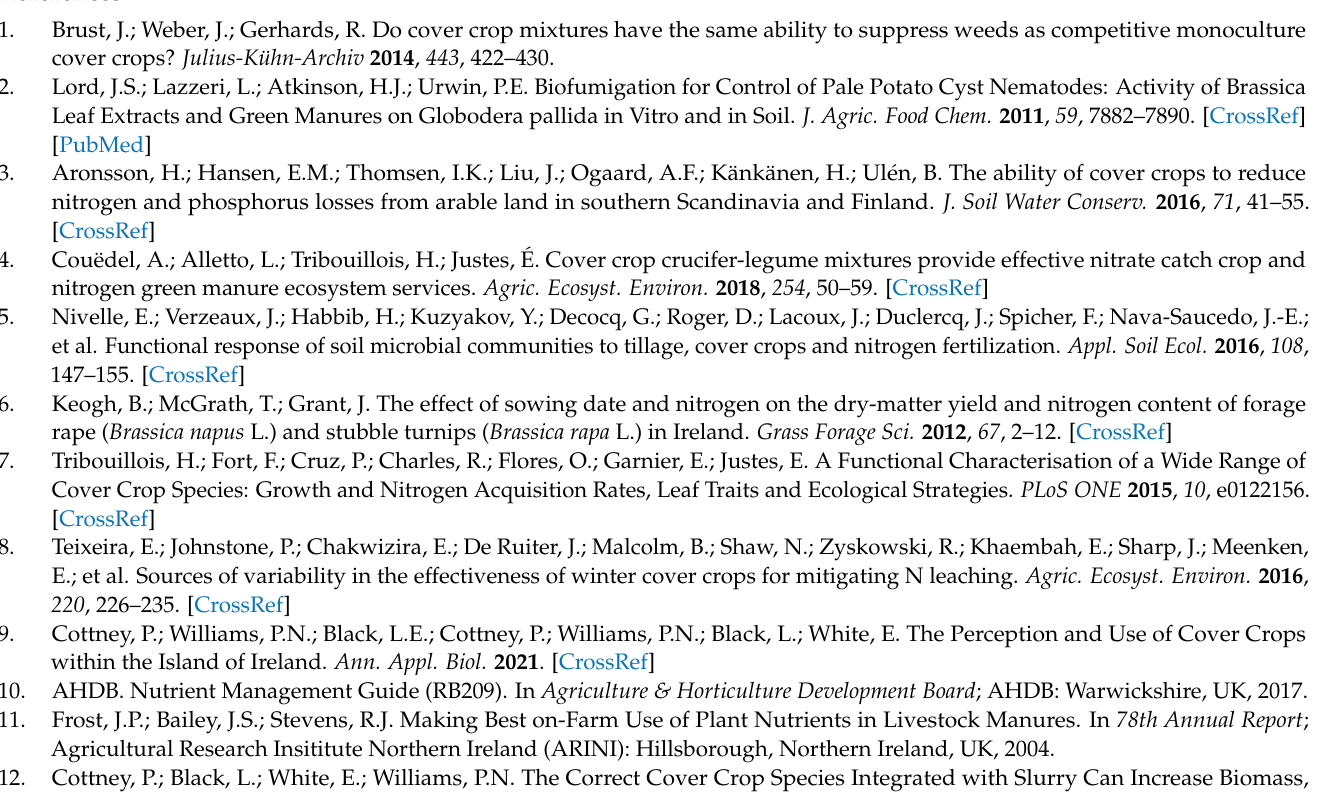
Figure A2. Temperature data during trial (°C). Mean monthly air and soil temperatures including monthly means and max temperatures recorded at Crossnacreevy, Belfast.